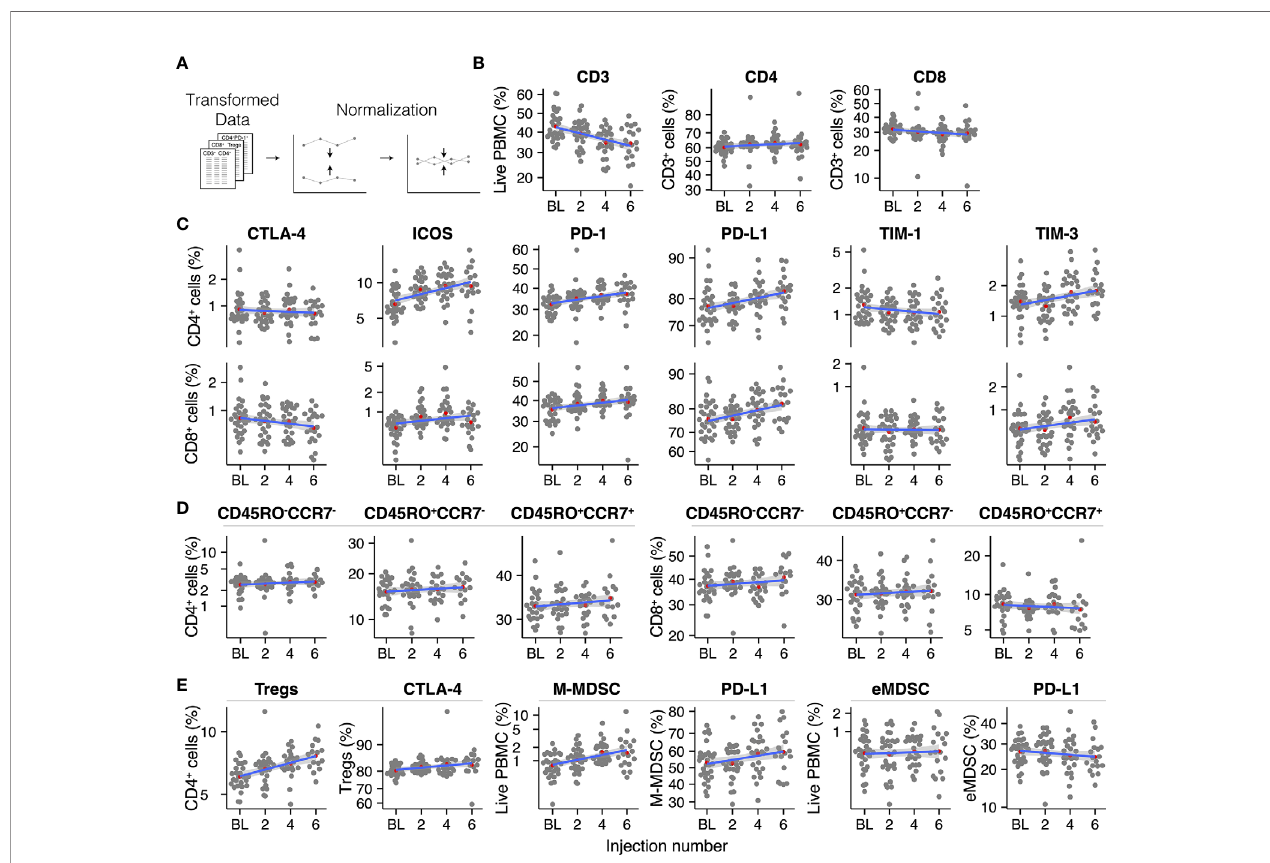
FIGURE 2 | Overview of the analyzed immune cell subsets throughout radium-223 treatment (A) Data pre-processing steps, (B) CD3 + , CD4 + , and CD8 + T cells, (C) Immune checkpoint-expressing T cells, (D) Memory and effector T cell subsets, (E) Immunosuppressive cell subsets. Red dots indicate the group means. The blue line represents the fi tted linear regression model, including 95%